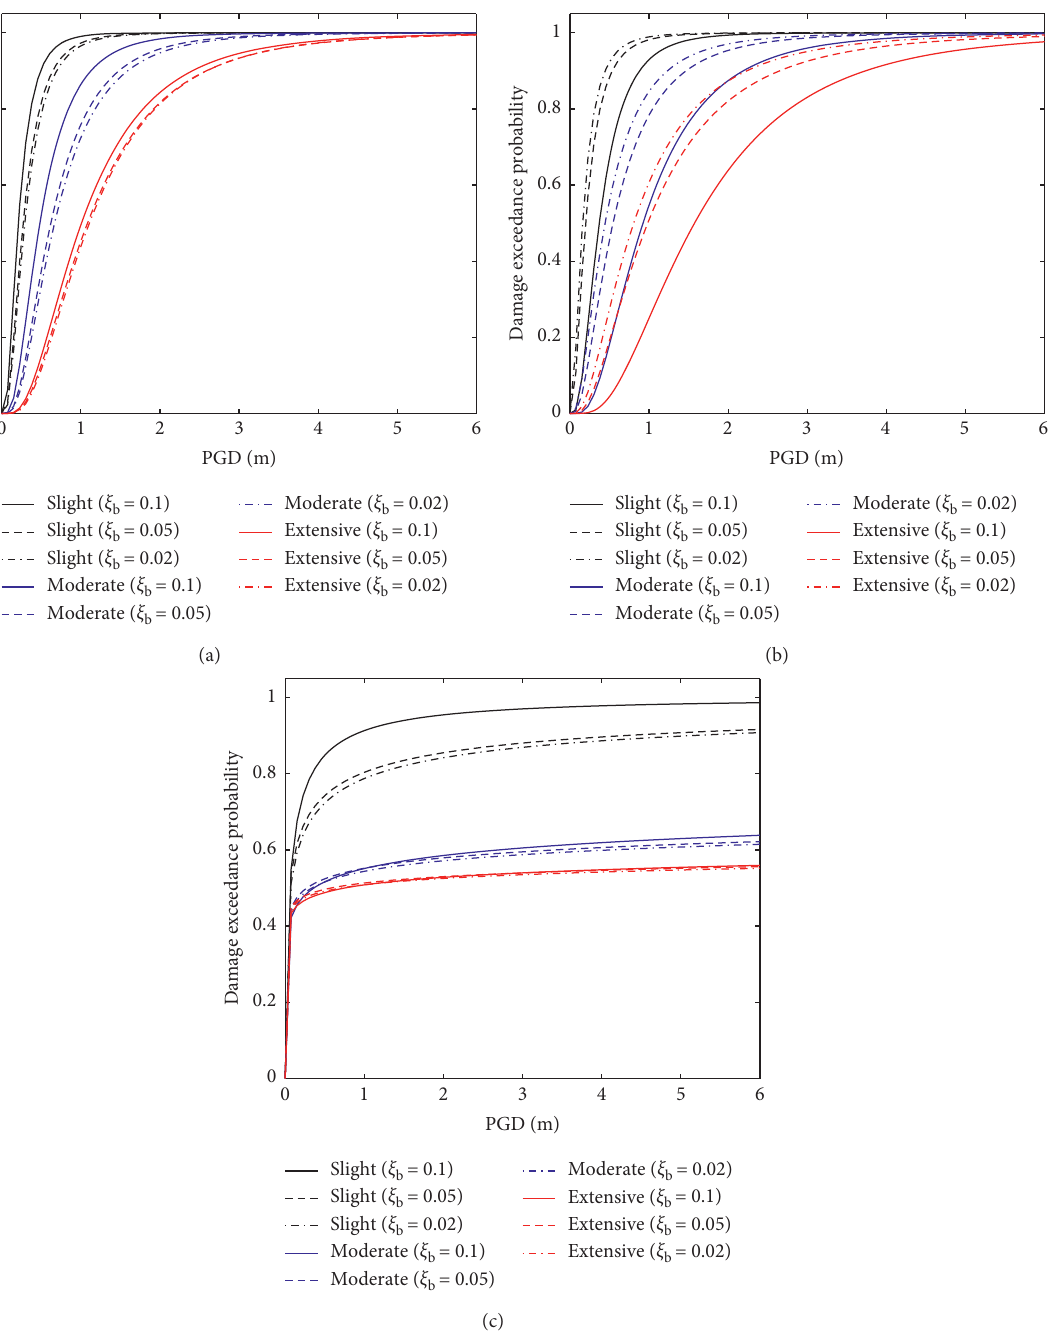
Figure 10: Influence of bearing damping ratio on fragility curve: (a) convective displacement; (b) bearing displacement; (c) base shear